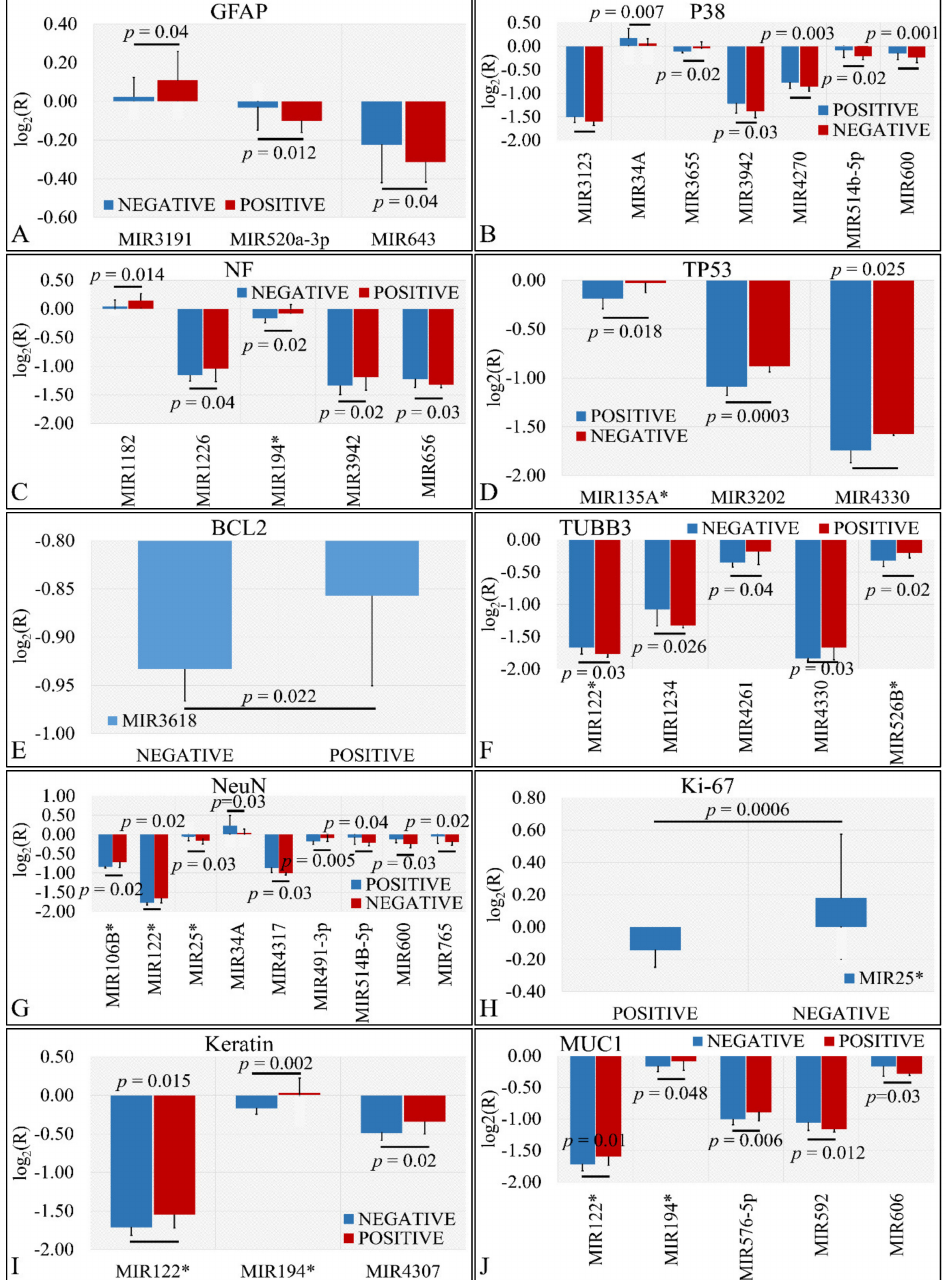
Figure 5. DE miRNAs with respect to protein markers. Significant differences were observed between tumor samples with positive or negative protein markers. In particular, significant differences were observed with respect to glial fibrillary acidic protein (GFAP) ( A ), P38 ( B ), Neuromicrofilaments (NF) ( C ), Tumor protein p53 (TP53) ( D ), Bcl2 apoptosis regulator (BCL2) ( E ), β -tubulin III (TUBB3) ( F ), RNA binding Fox-1 homolog 3 (NeuN) ( G ), Marker of proliferation Ki-67 (Ki-67) ( H ), Keratin ( I ), and Mucin 1 cell surface associated (MUC1) ( J ) (Legend: R: Relative expression, where R = E tumors expression levels of controls and tumors,